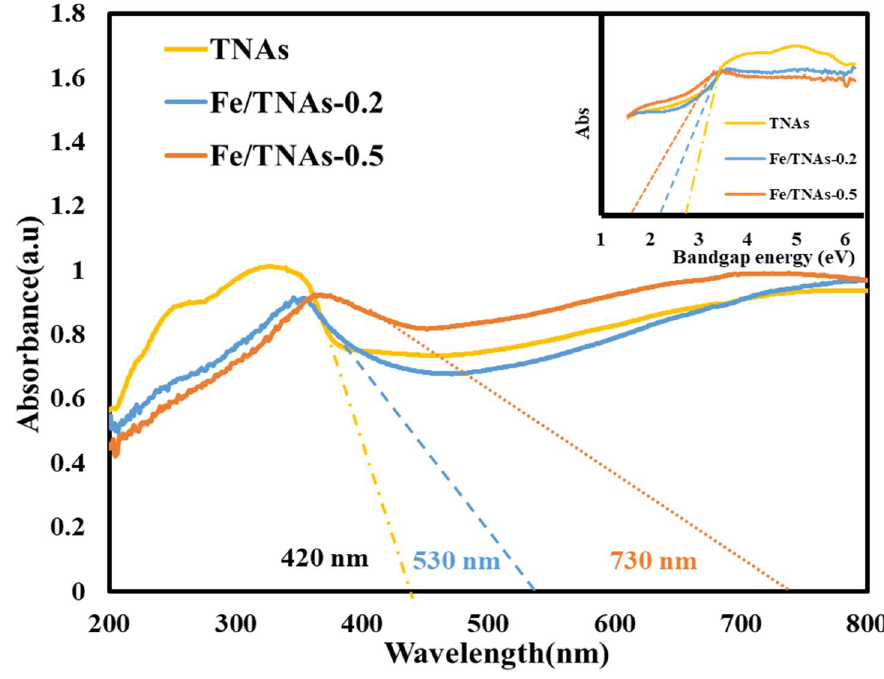
Figure 4. UV-vis DRS spectra of TNAs, Fe/TNAs-0.2, and Fe/TNAs-0.5; insert plot: bandgap energy for TNAs, Fe/TNAs-0.2, and Fe/TNAs-0.5.